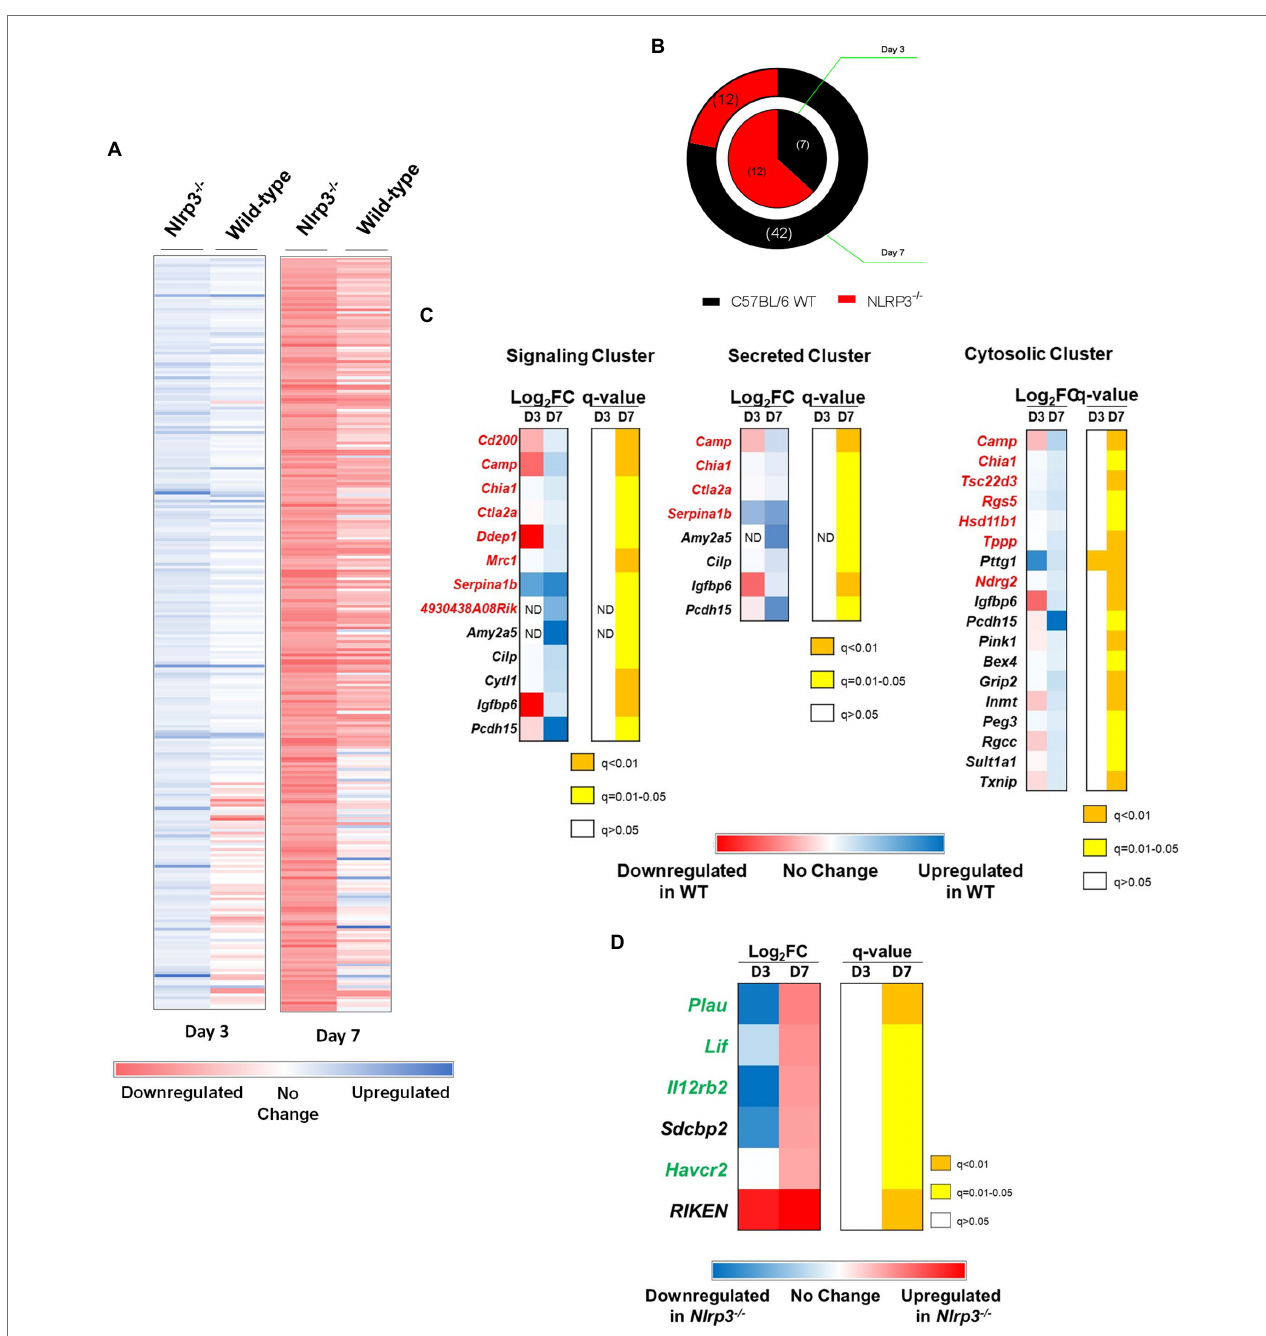
FIGURE 8 | Genes known to enhance the host’s susceptibility to F. tularensis infection are downregulated in Nlrp3 − / − mice. Wild-type and Nlrp3 − / − mice were infected intranasally with 1 × 10 4 CFU of F. tularensis LVS. Total RNA was isolated from lungs of infected mice on days 3 and 7 post-infection and sequenced to determine the expression of various genes in the mouse by RNA-sequencing. The genes were aligned and their expression profile over time has been represented as a heat map of the Log 2 Fold change. (A) Expression profile of genes that were significantly differentially expressed ( q < 0.05) in wild-type and Nlrp3 − / − mice. (B) Pie chart representing significantly expressed genes between wild-type and Nlrp3 − / − mice. The inner ring represents the expression profile of the indicated mouse strain on day 3, while the outer ring represents the expression profile on day 7 post-infection. The numbers of differentially expressed genes are shown in the parenthesis. (C) DAVID genomics and clusters based on functional annotation of genes in F. tularensis LVS-infected wild-type and Nlrp3 − / − mice on day 3 and 7 post-infection. (D) Differential expression of genes in Nlrp3 − / − mice known to have a protective role against F. tularensis infection. The expression profile is presented as heat maps alongside corresponding q values. Genes in red font are known to enhance the susceptibility of the host to F. tularensis , while those in green have a protective role. Data shown are cumulative of transcript levels using RNA isolated from lungs of F. tularensis- infected mice ( n = 3/time point/group) on days 3 and 7